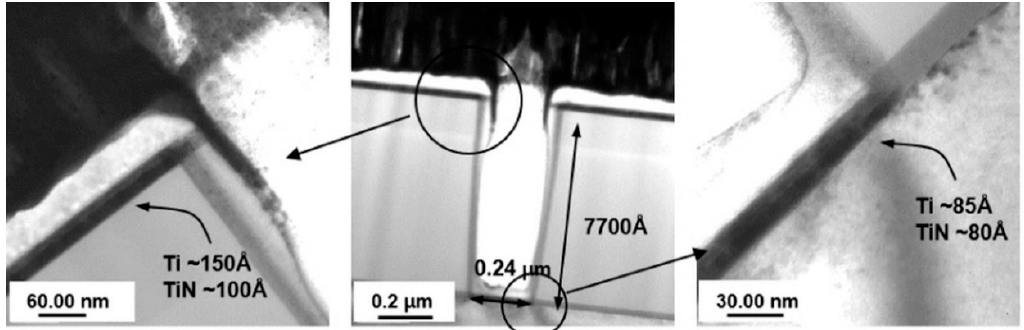
Figure 2. TEM image of cross section after each film is deposited using HRS0005 with complete contact hole definition.